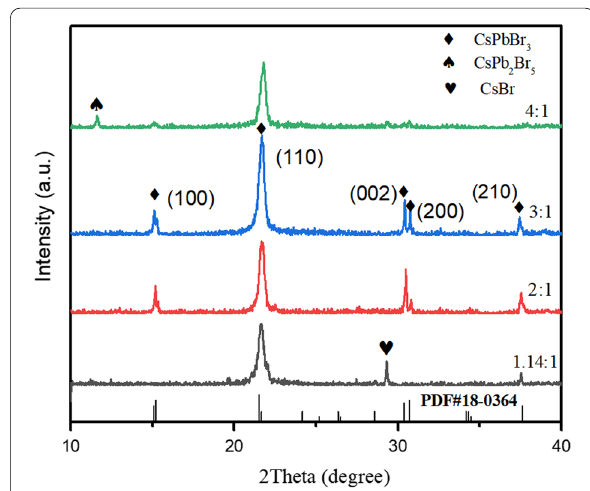
Fig. 1 XRD patterns of CsPbBr 3 films with different evaporation rate ratios